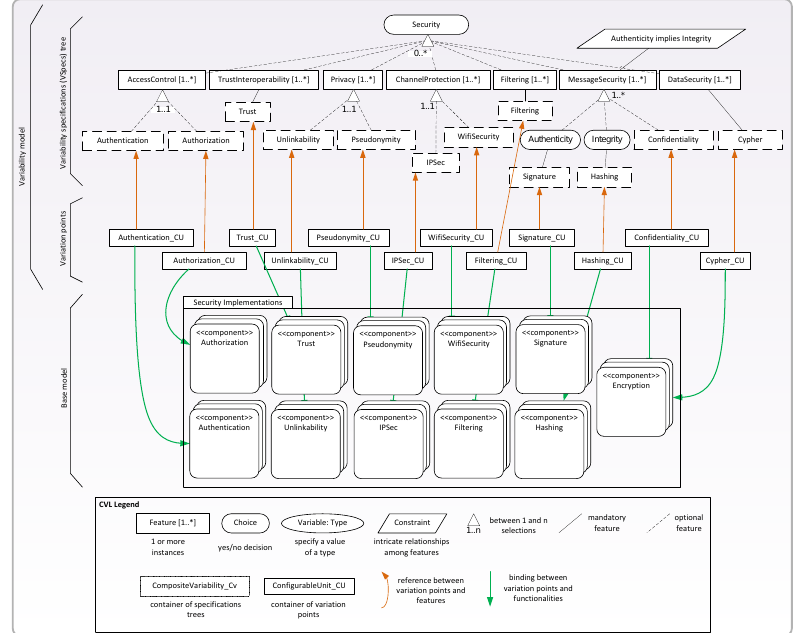
Figure 6. Composite variability: security concerns.